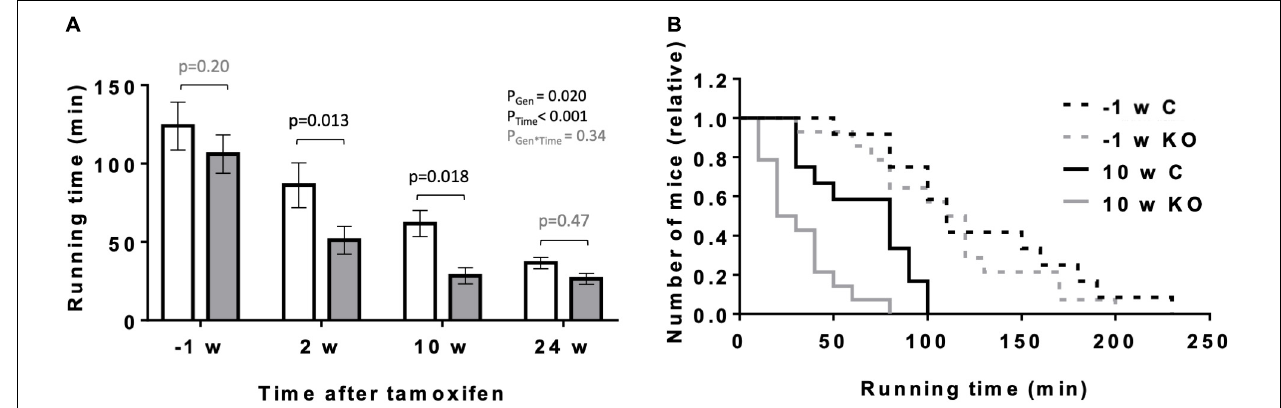
FIGURE 5 | Effect of cardiomyocyte-specific AMPK α 1 and α 2 deletion on exercise capacity of mice. (A) Exercise capacity (running time till exhaustion) of mice of the both genotypes 1 week before and 2, 10, and 24 weeks after tamoxifen administration. Control (white bar), KO (gray bar). (B) Frequency distributions of till exhaustion running times in mice of the both genotypes 1 week before and 10 weeks after tamoxifen administration. Data are presented as means ± SEM; n = 12 control and 14 KO. In panel (A) data were analyzed by 2-way Repeated Measure ANOVA followed by Holm–Sidak test for pairwise comparisons. Resulting significance values are given for two main effects related to genotype P Gen , time P Time , and their interaction P Gen × Time ; pairwise comparisons between two genotypes are performed for different time points; the resulting p -values are